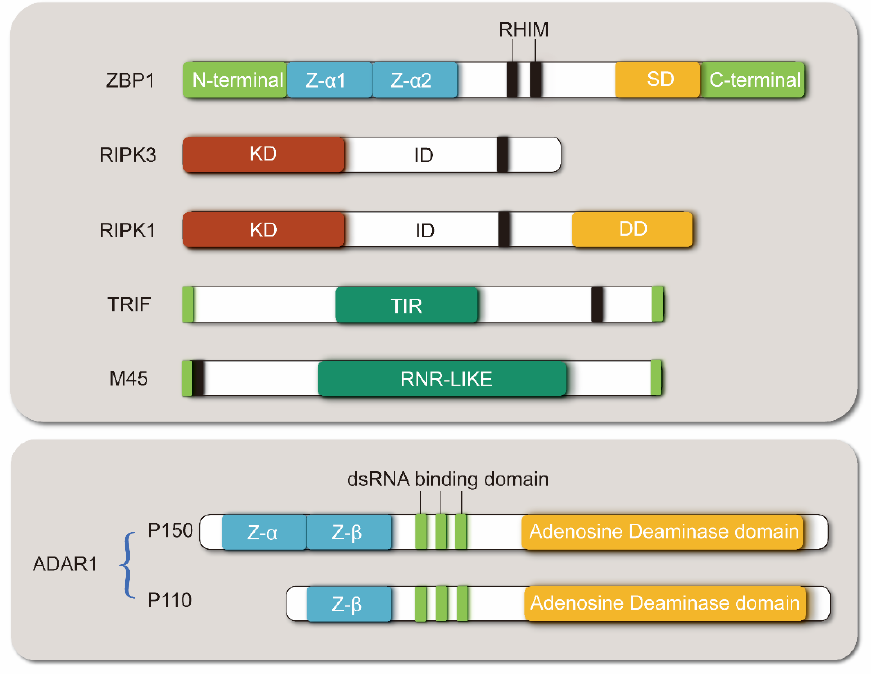
Figure 1. Structural diagram of ZBP1 and its interacting proteins.